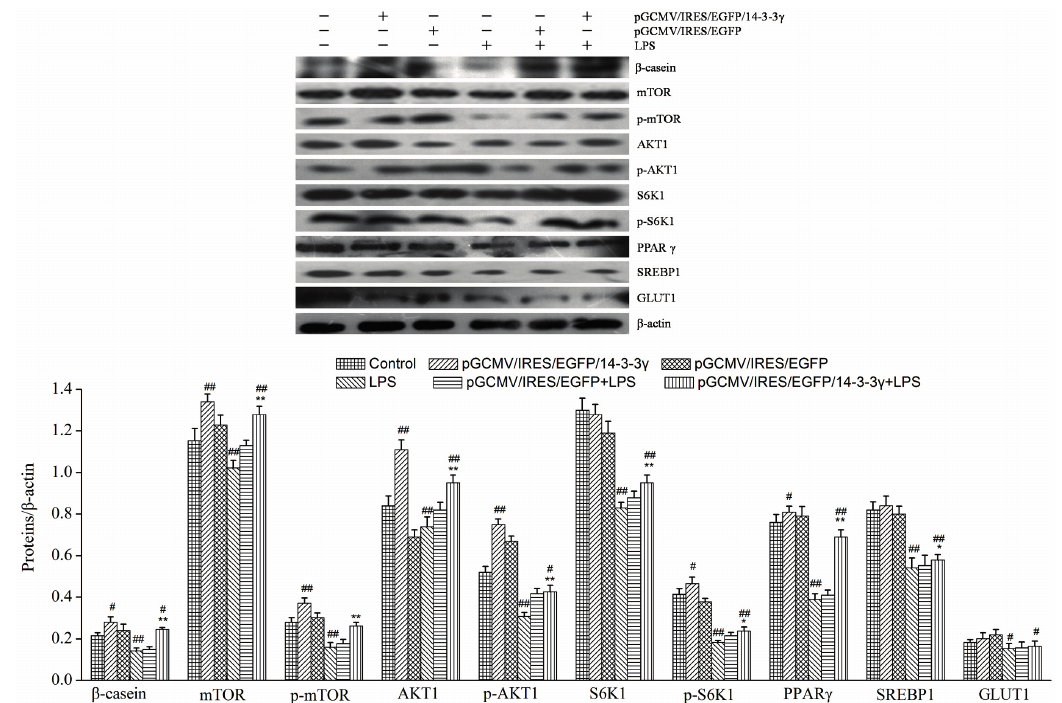
Figure 9. Effects of 14-3-3 γ overexpression on lactation-associated proteins in LPS-induced